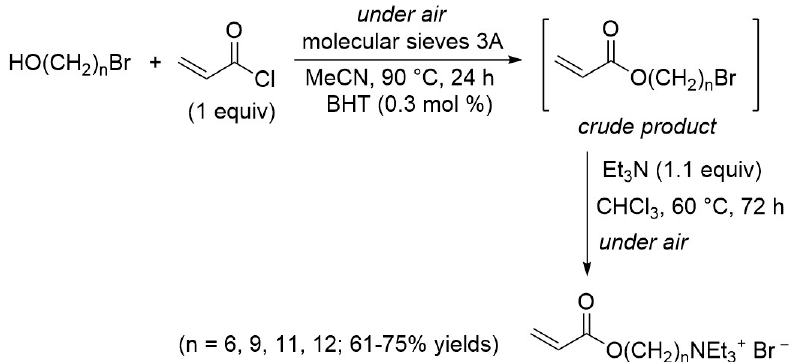
Figure 2. Synthetic scheme for acryloxyalkyltriethylammonium bromides (AATEABs)